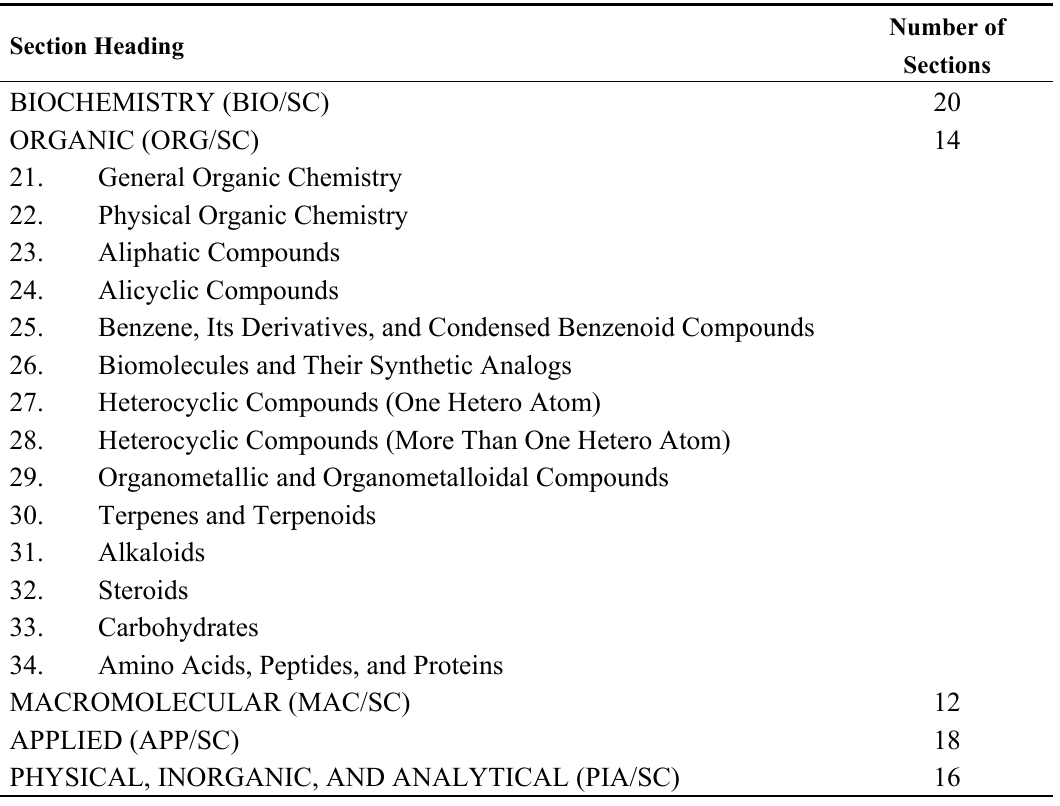
Table 1. Summary of Chemical Abstracts (CA) Section Headings. For Organic Chemistry the individual sections are listed for